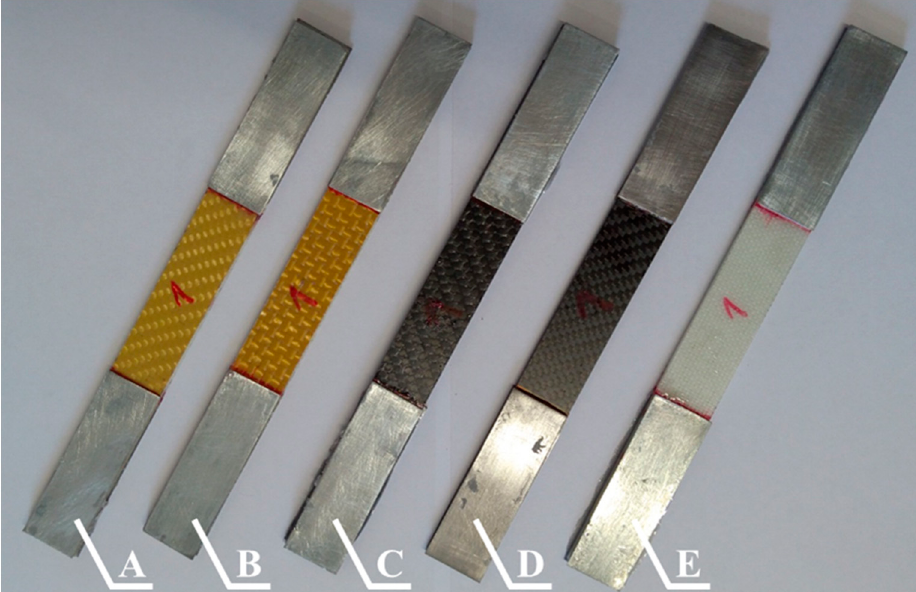
Figure 9. Selected epoxy composites samples (with steel covers) reinforced by the following fibers: A —Twaron 2200, B —Kevlar 49, C —Pyrofil TR30 S, D —HR 12K, E —Dyneema SK 60. A —Twaron 2200, B —Kevlar 49, C —Pyrofil TR30 S, D —HR 12K, E —Dyneema SK